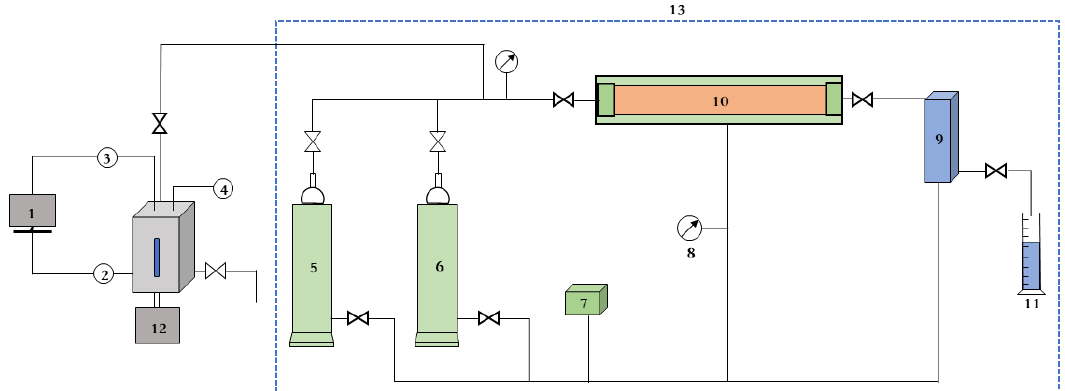
Figure 4. Core damage test system. 1—Temperature and pressure control system; 2—temperature